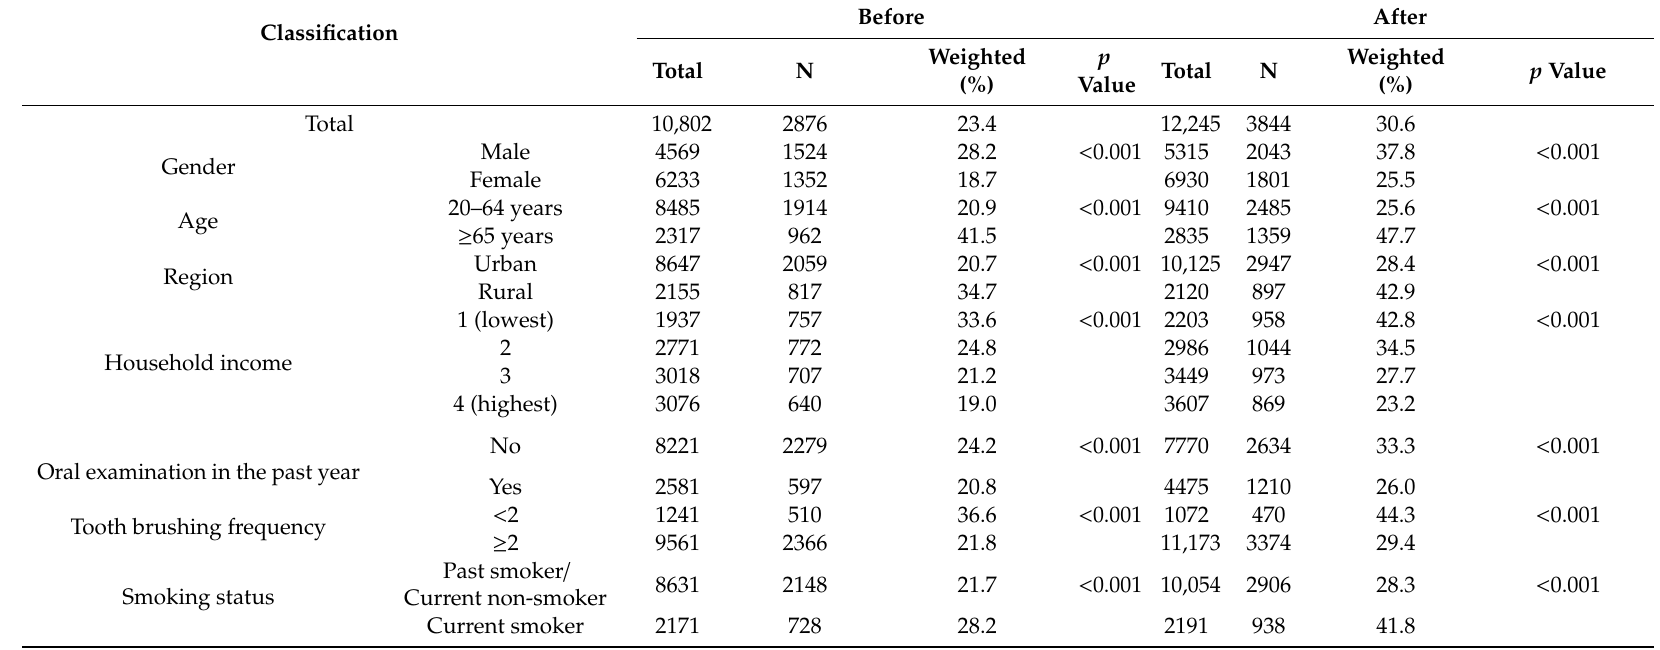
Table 4. Changes in the prevalence of periodontal diseases according to health insurance coverage for dental scaling.